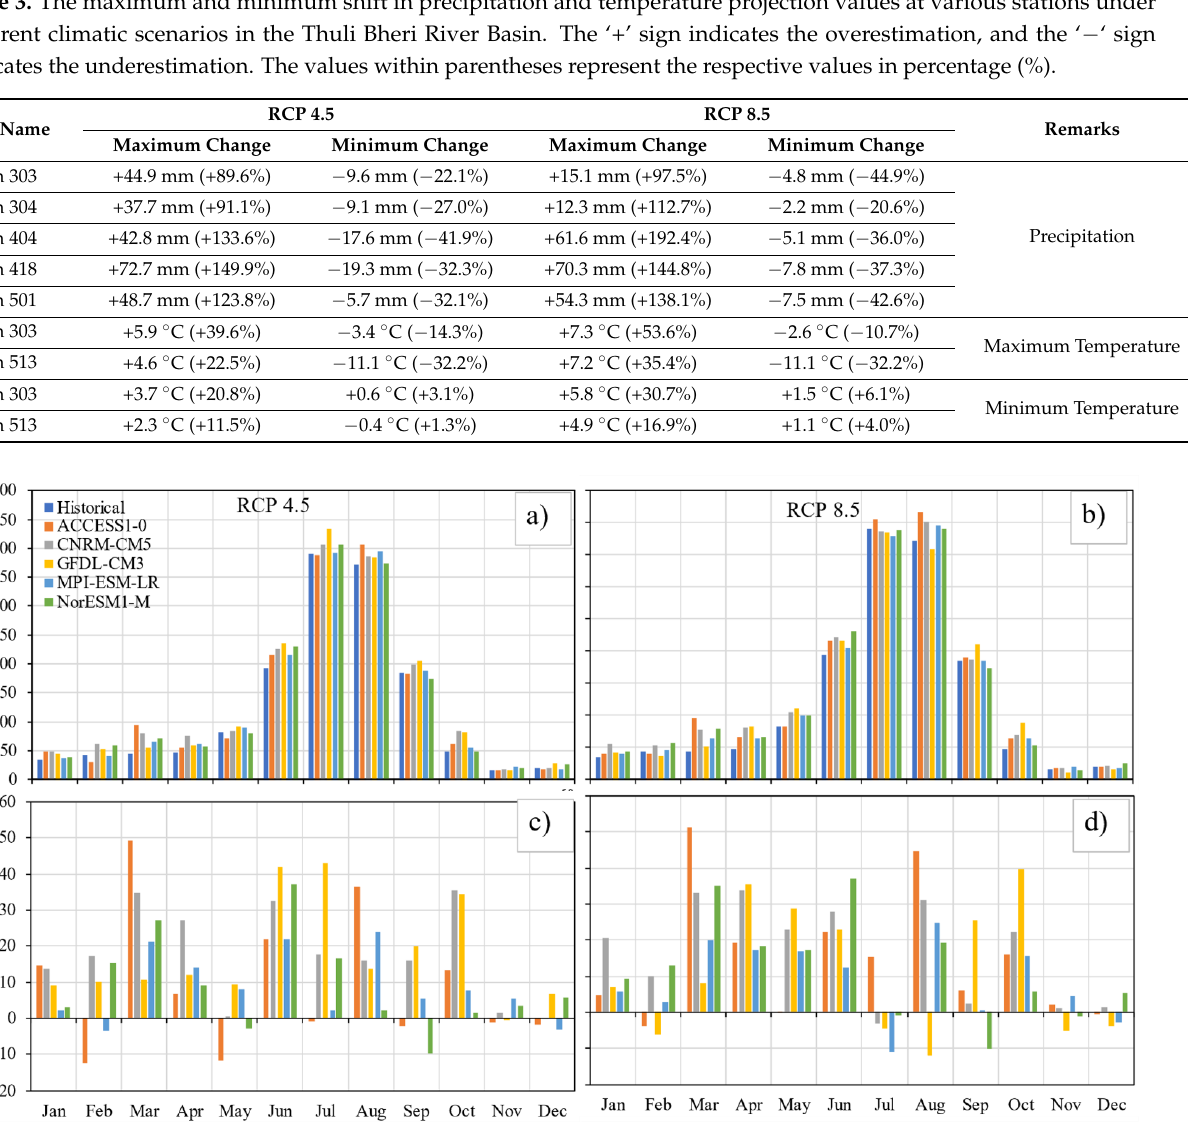
Figure 3. The monthly average projected and percentage change in precipitation using multiple climate models under RCP 4.5 and 8.5 scenarios. ( a , c ) show the projected precipitation and percentage change in precipitation amount under the RCP 4.5 emission scenario. ( b , d ) show the same under the RCP 8.5 emission scenario.